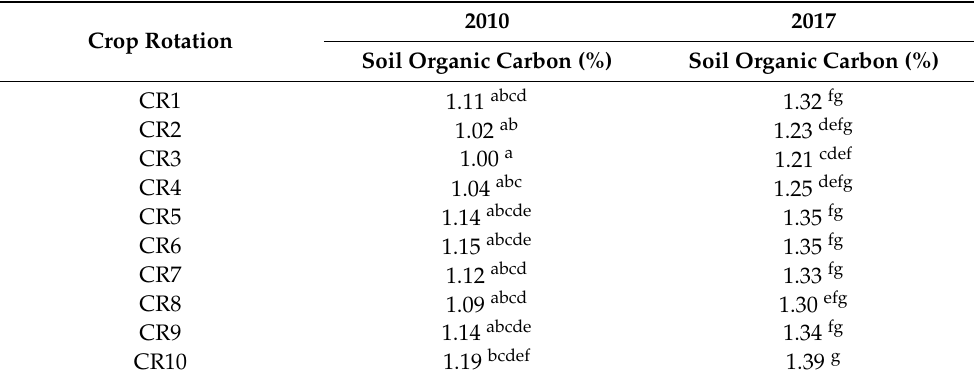
Figure 3. ( a ) SOCc (%) in 2010 for each crop rotation (CR). ( b ) SOCc (%) in 2017 for each CR. Unfertilised plots are represented by grey boxes, fertilised plots by black boxes ( n = 48 for CR1, n = 16 for all other CRs). Boxes represent the interquartile range (IQR), the line within each box represents the median, whiskers extend to a maximum of 1.5 × IQR beyond the box. See Table 6 for significant differences between CRs. Table 6. Soil organic carbon content (%) for each crop rotation (fertilised and unfertilised plots combined, n = 96 for CR1, n = 32 for all other CRs) in 2010 and 2017 (estimated marginal means; means sharing a letter are not significantly different, p < 0.01).